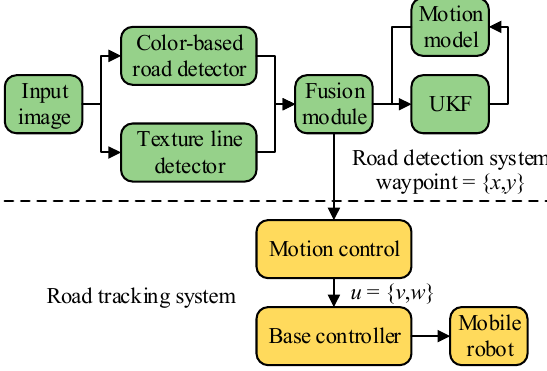
Figure 2. Structure diagram of the vision-based road-following system.